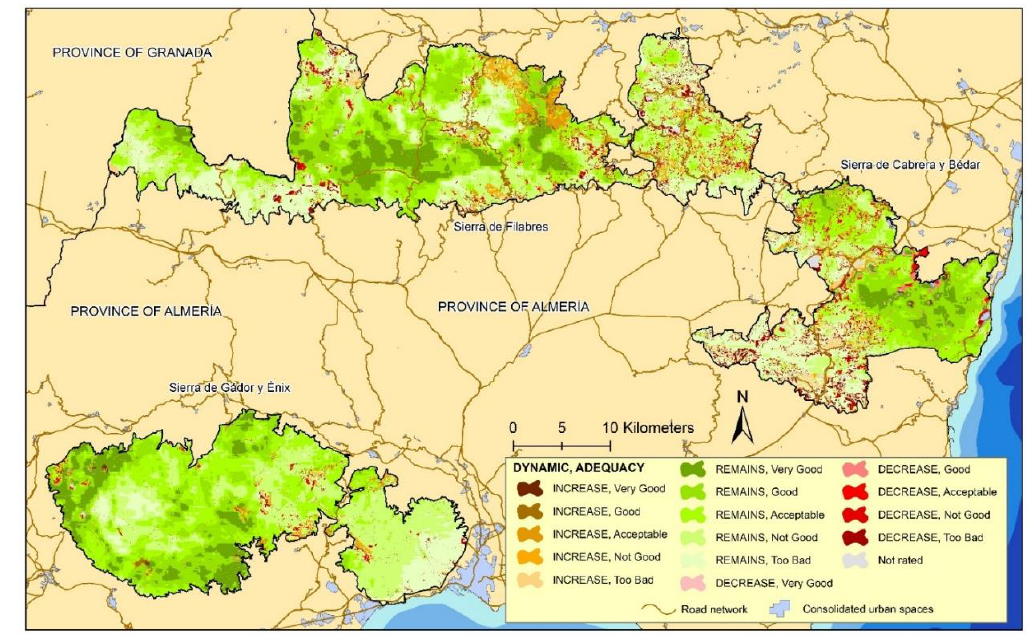
Figure 10. Dynamics of changes in vegetation cover (1991 – 2021). Natural areas to the east of the study area. Province of Granada and Almeria. Own elaboration based on data of Cartography of the Uses and Vegetation Covers of the soil of Andalusia (1991) and the Geographical Information System for the Identification of Agricultural Land Parcels (SIGPAC) (2021). Table 9. Dynamics of change (1991–2021). Area in hectares. Natural Areas